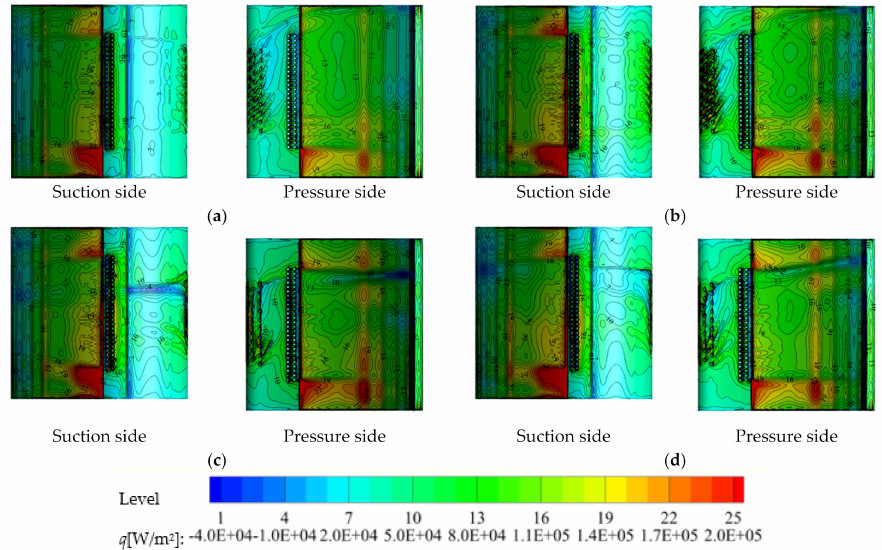
Figure 14. Local heat flux distribution for different cases. ( a ) Case 1: uniform inlet; ( b ) Case 2: HS only; ( c ) Case 3: HS and positive swirl; ( d ) Case 4: HS and negative swirl.